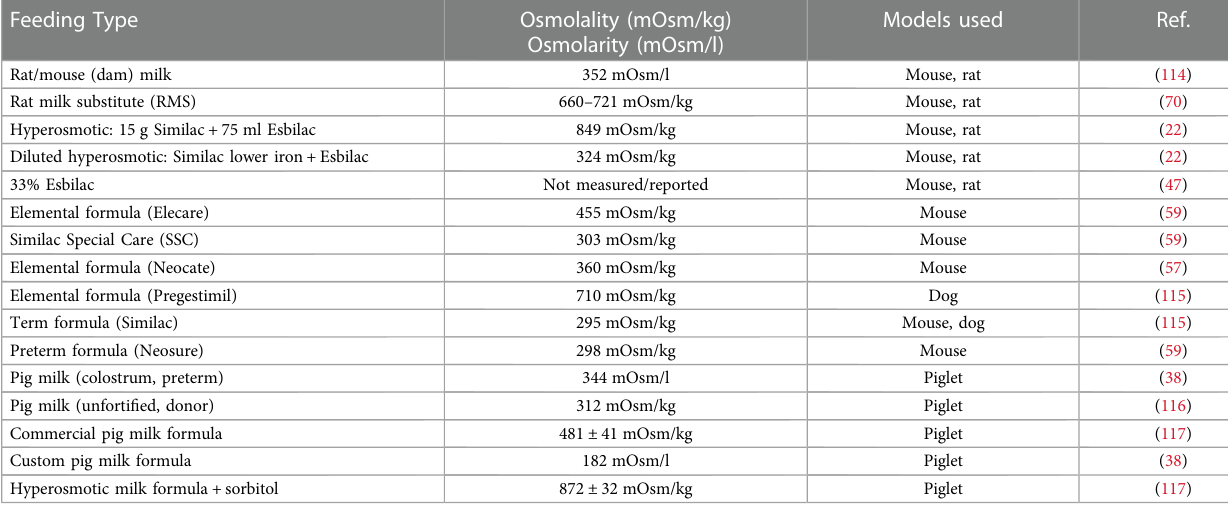
TABLE 2 Feeding type formulation and reported